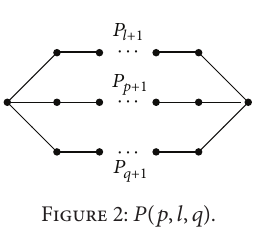
Figure 2: 𝑃(𝑝,𝑙,𝑞)